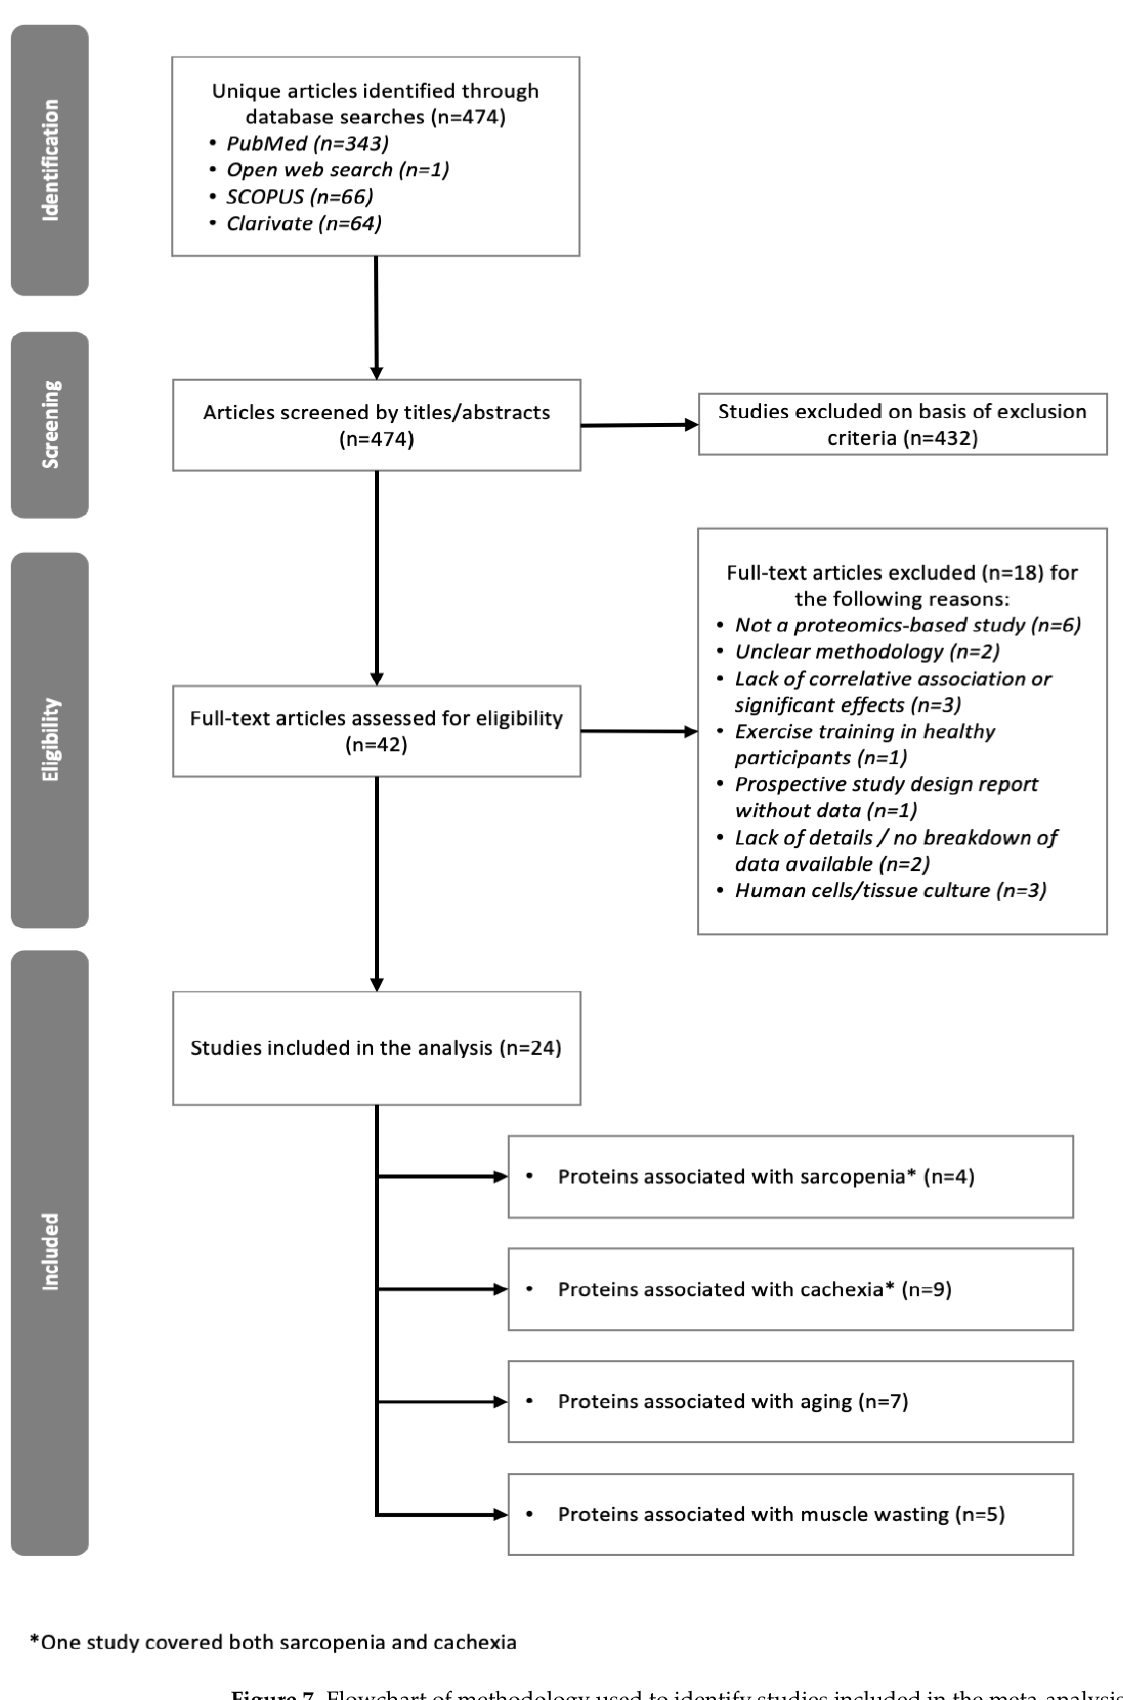
Figure 7. Flowchart of methodology used to identify studies included in the meta-analysis.